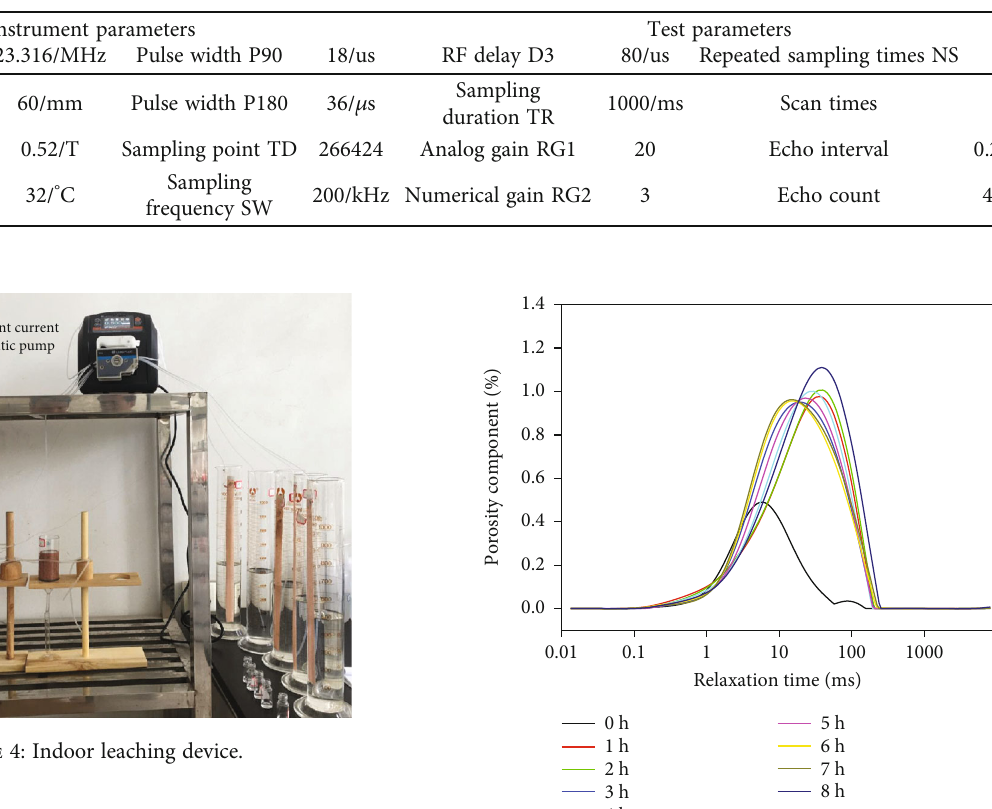
Figure 5: T 2 curves of A1 sample at di